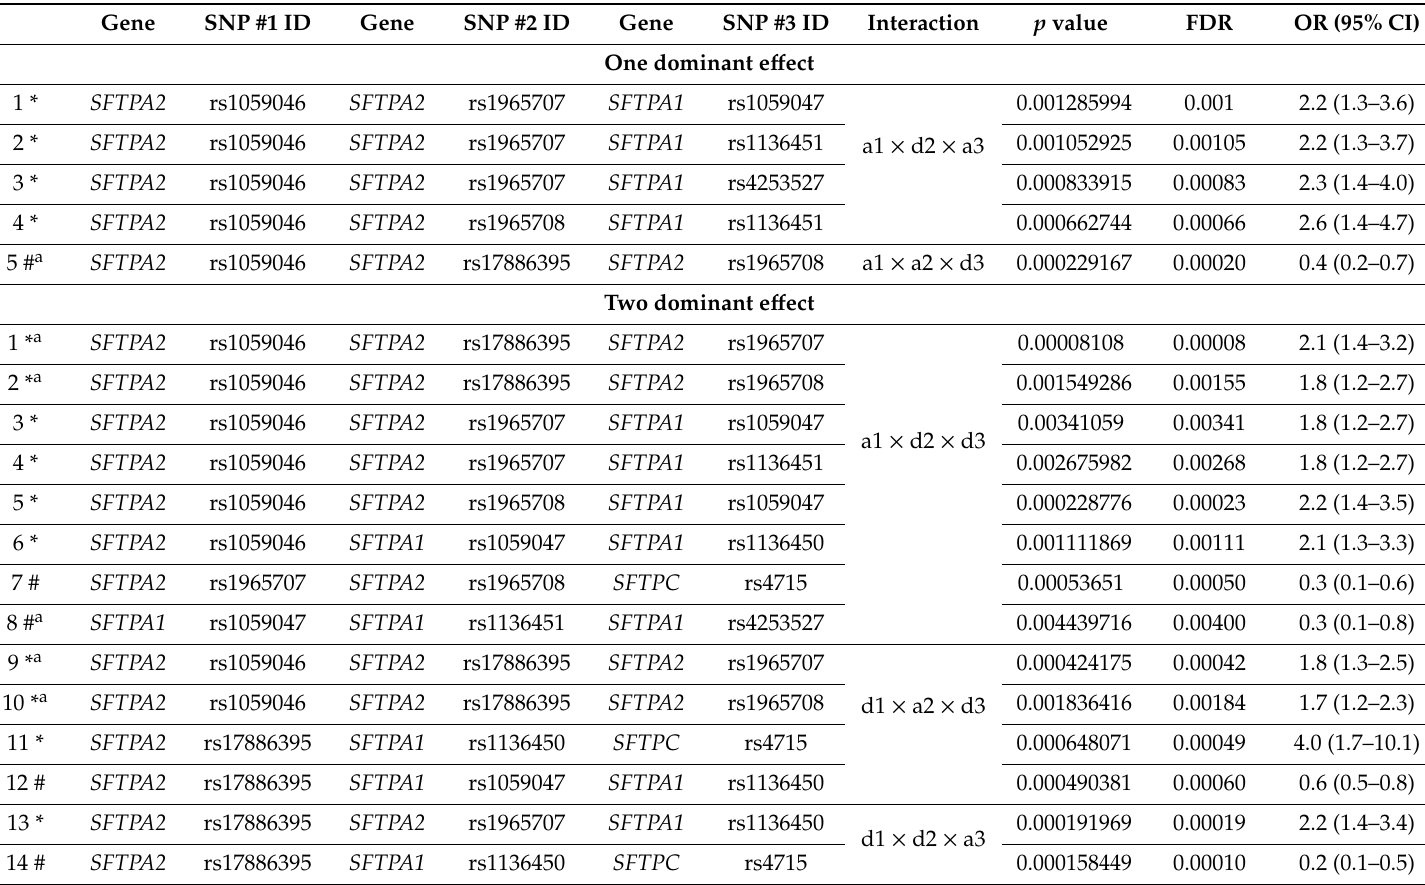
Table 2. Association of SNPs of SP genes with ARF compared to newborn controls after adjusting for sex and